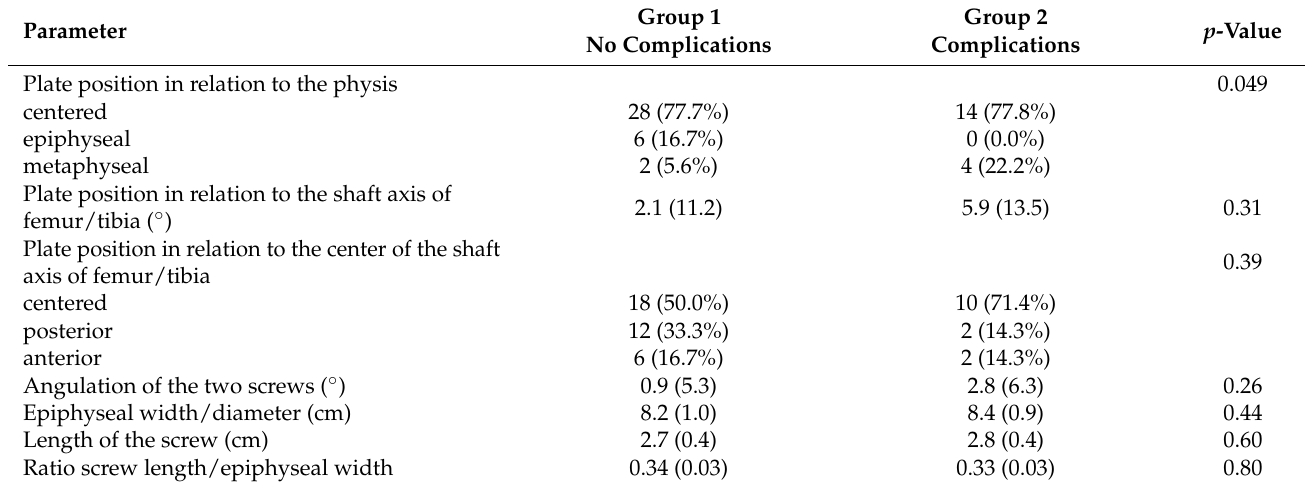
Table 2. Radiographic evaluation of implant